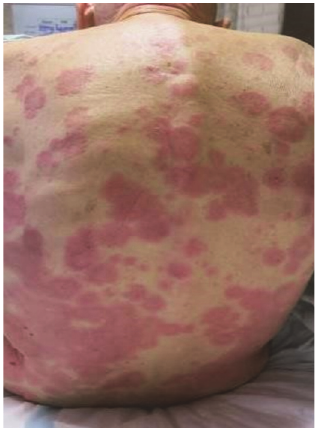
Figure 4: Back with extensive annular erythematous coalescing lesions.